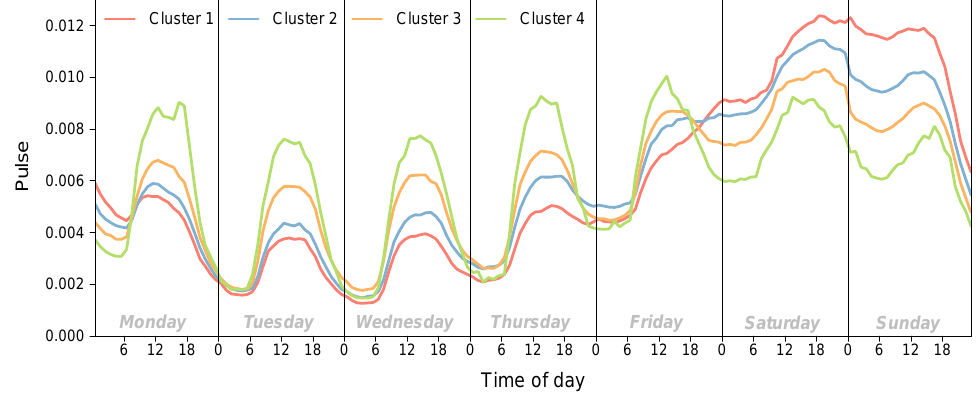
Figure 1. Average pulse associated with the four clusters. Plots displaying the standard deviations are available in Figures A7 and A8. It is worth noting that the fraction of reliable users (i.e., mobile phone users with a validated home location) is stable between the different clusters (Figure A9 in Appendix